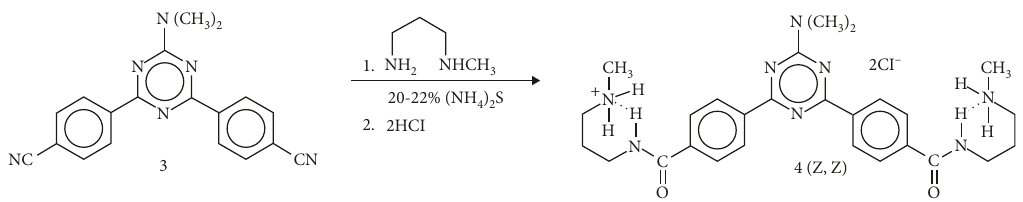
Scheme 3: Preparation of dicationic diaryltriazine 4 . An important system in structure formation with lacking hydrogen bonds in the intermediate is a main driving force towards the Z isomeric form.